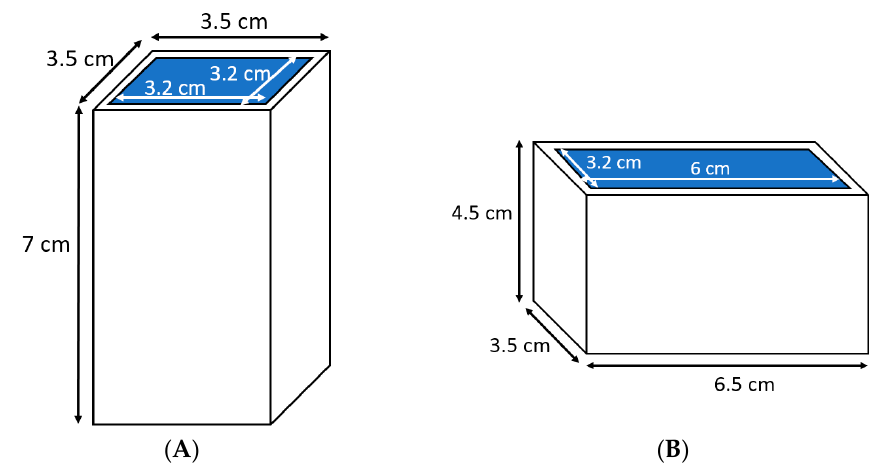
Figure 1. Two Teflon beakers used to measure the absorbed power of DDI water for ( A ) vertical and ( B ) horizontal orientations.